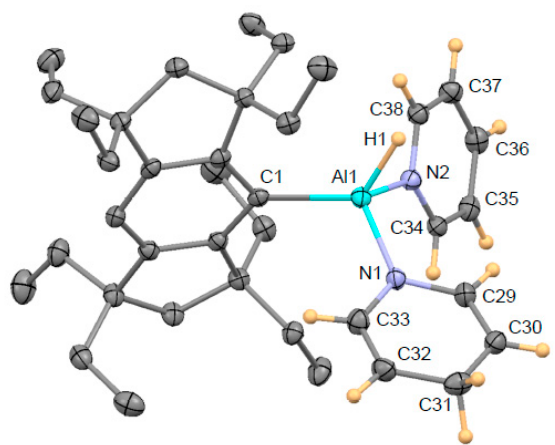
Figure 1. Molecular structure of 3 . The thermal ellipsoids are shown at the 50% probability level. The hydrogen atoms of the Eind group are omitted for clarity.